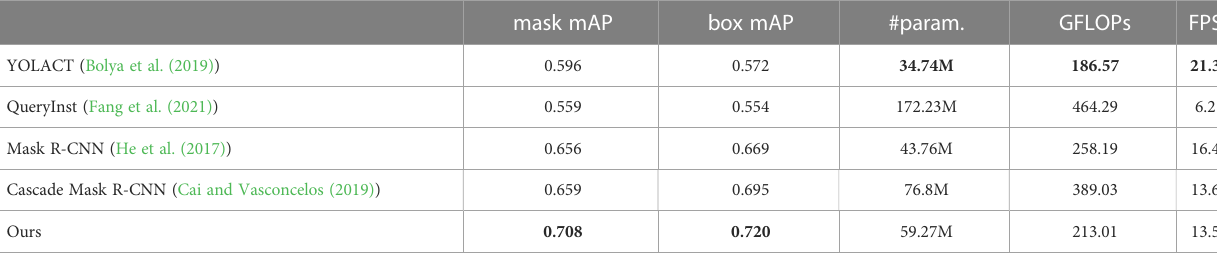
TABLE 2 Performance comparison with state-of-the-art methods.